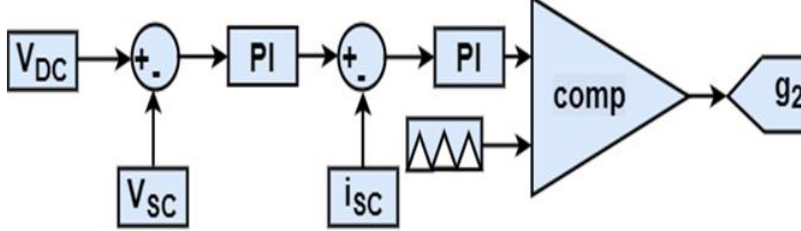
Figure 9. Overview of the FC-SC HEV.